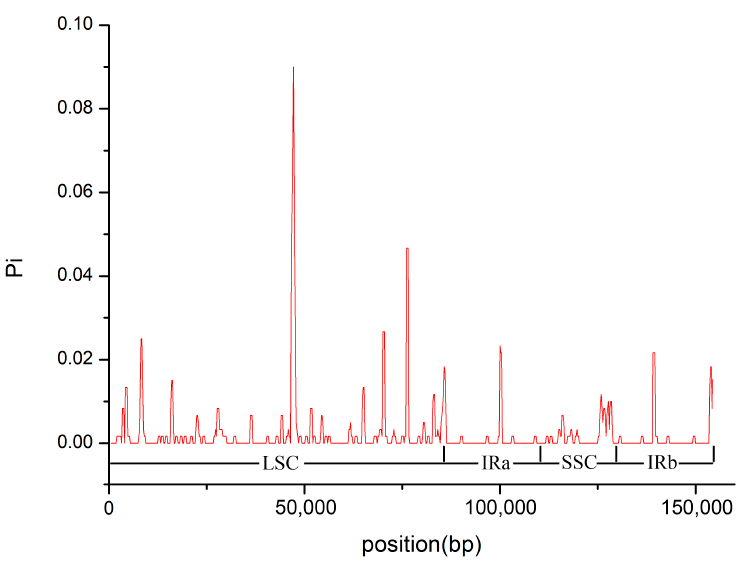
Figure 5. Sliding window analysis of nucleotide variability (pairwise divergence) between Lancea tibetica and L . hirsuta .